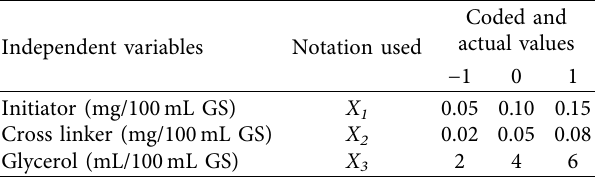
Table 1: Coded and actual values of independent variables. Independent